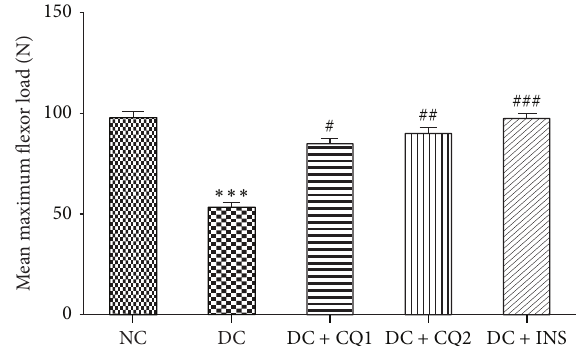
Figure 4: Effect of PECQ on mean maximum flexor load of femur. Mean maximum flexor load significantly decreased in diabetic control (DC) rats when compared to normal control (NC) rats. Treatment with two different doses of PECQ (DC + CQ1 and DC + CQ2) or with insulin (DC + INS) significantly increased the mean maximum flexor load in diabetic rats when compared to DC rats. ∗∗∗ 𝑃 < 0.001 whencomparedtoNCgroup; ### 𝑃 < 0.001 , ## 𝑃 < 0.01 , and # 𝑃 < 0.05 when compared to DC group.